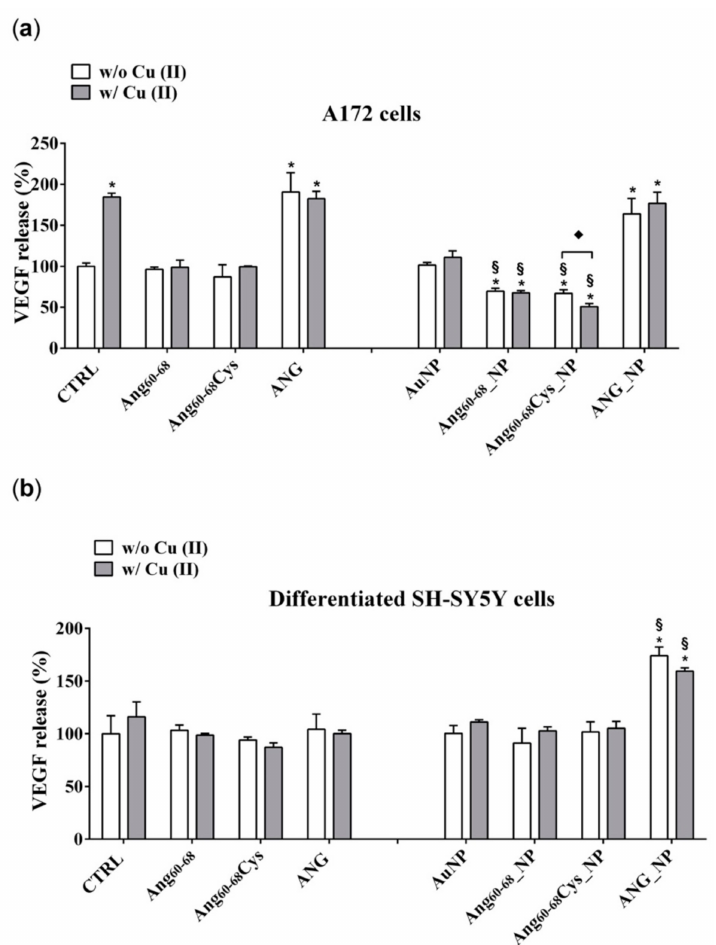
Figure 6. Vascular endothelial growth factor (VEGF) release in the medium of confluent cultures of A172 ( a ) and di ff erentiated d-SH-SY5Y cells ( b ). Cells were grown in basal culture medium (control: CTRL) and in culture medium supplemented with: Ang 60–68 (30 µ M), Ang 60–68 Cys (30 µ M); ANG (100 nM), AuNP (9.4 nM = 1.4 × 10 8 NP / mL), Ang 60–68 _NP (1.4 nM = 4.0 × 10 6 NP / mL, [Ang 60–68 ] = 2.8 × 10 − 12 M), Ang 60–68 Cys_NP (1.4 nM = 4.0 × 10 6 NP / mL, [Ang 60–68 Cys] = 2.6 × 10 − 12 M), ANG_NP (1.2 nM = 3.4 × 10 6 NP / mL, [ANG] = 0.2 × 10 − 12 M). All conditions were evaluated in presence or absence of metal ions (copper sulphate: Cu(II), 20 µ M). Sandwich enzyme-linked immunosorbent assay (ELISA) with monoclonal anti-VEGF antibody was used. The bars represent means ± SD of three independent experiments performed in triplicate (S.D. = standard deviation). Statistically significant di ff erences, determined by one-way analysis of variance ANOVA are indicated: * p ≤ 0.05 versus CTRL; § p ≤ 0.05 versus the respective treatment with free peptides / protein; (cid:7) p ≤ 0.05 versus the same treatment w / o Cu